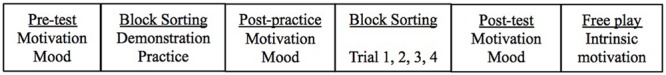
Procedure of the current study.